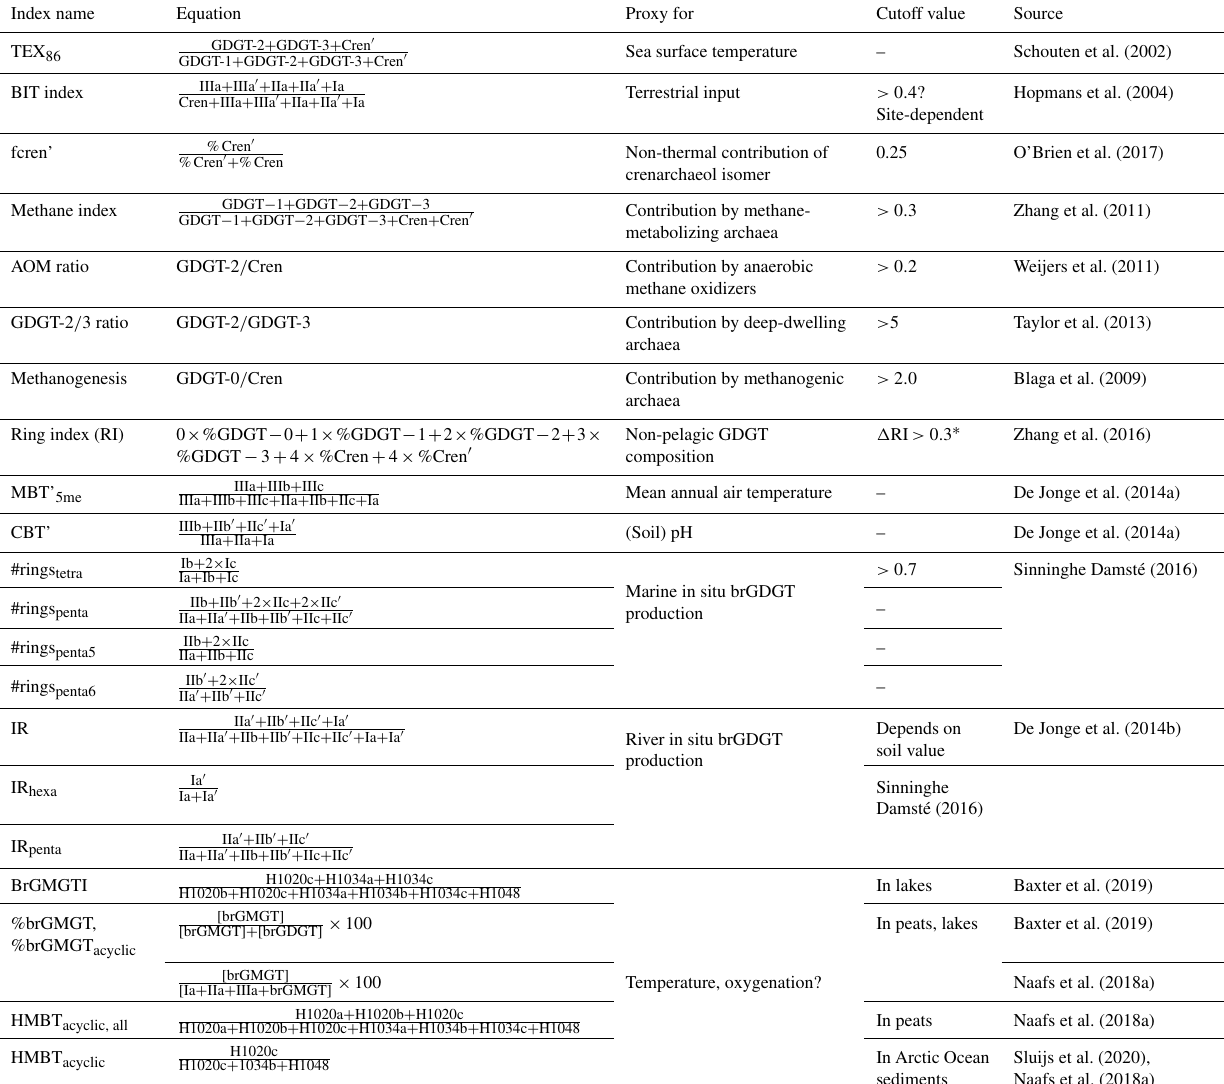
Table 1. Indices from iso- and brGDGTs and brGMGTs. For the chemical structure of these components, see Fig.